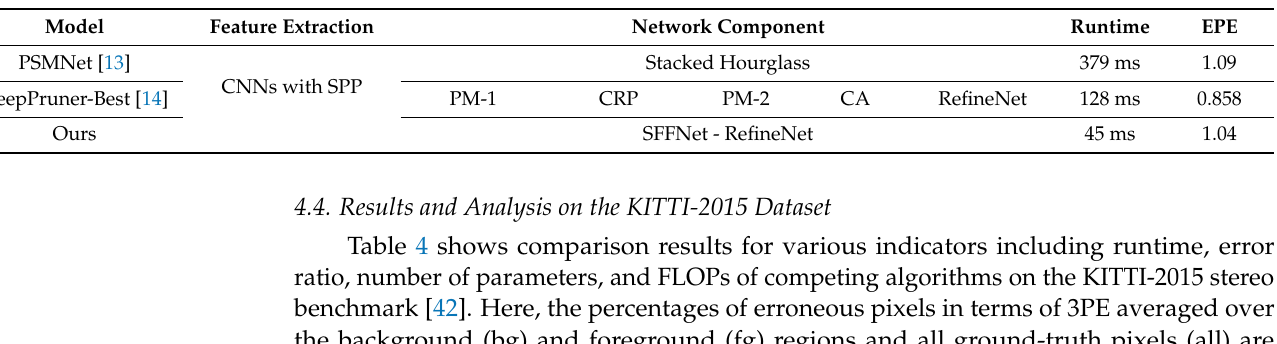
Table 3. Comparison results of runtime and EPE on the Scene Flow test set. *SPP: Spatial Pyramid Pooling, *PM: Patch Match, *CRP: confidence range predictor, *CA: cost aggregation.